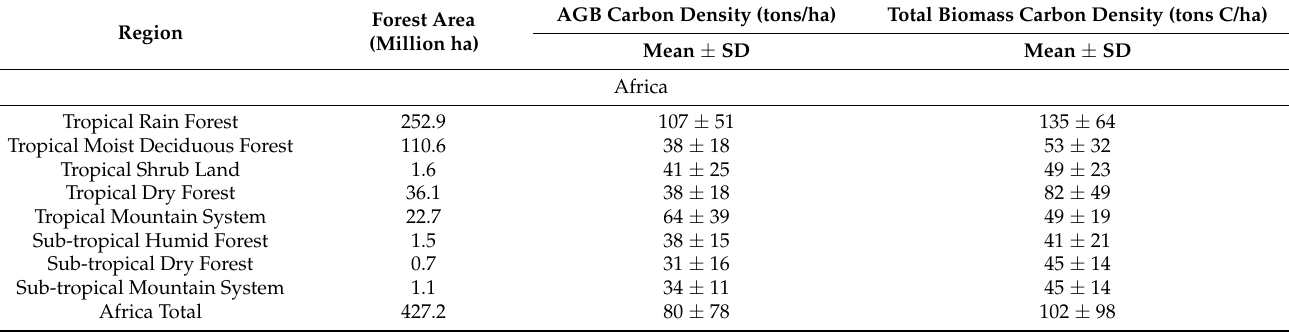
Table 2. Carbon stocks around three continents in the tropical